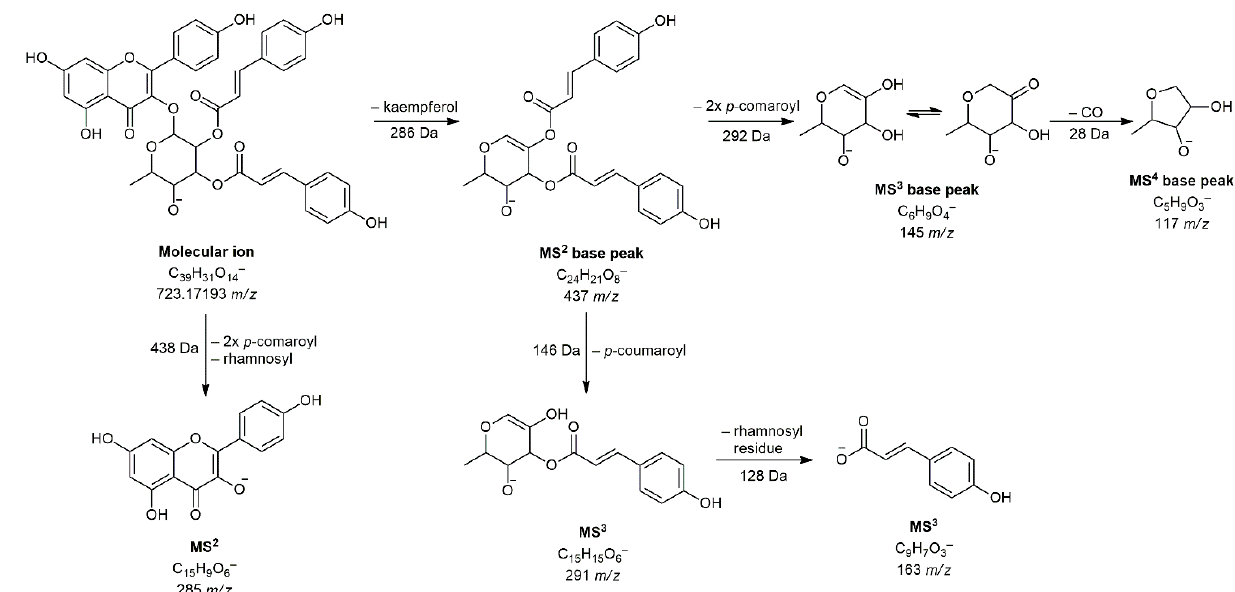
Figure 1. Schematic representation of fragmentation of compound 31 (kaempferol 3- O -(2 ″ ,3 ″ -di- p -coumaroyl)-rhamnoside).